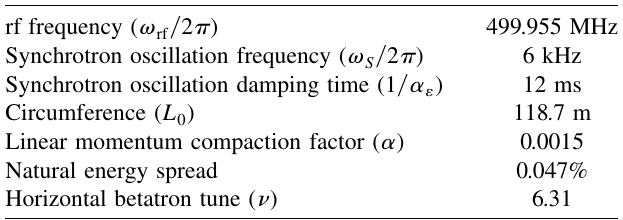
TABLE I. Main parameters of NewSUBARU at 1 GeV.